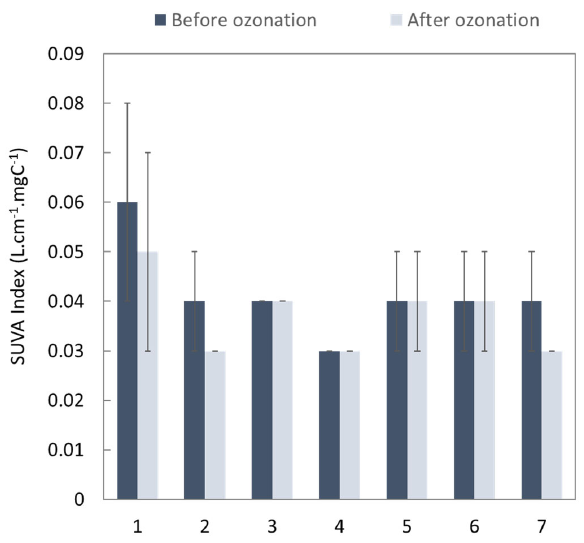
Figure 5. SUVA 254 index before and after each ozonation experiment. The number in the x ‐ axis corresponds to the number of the experiments in Table 5.